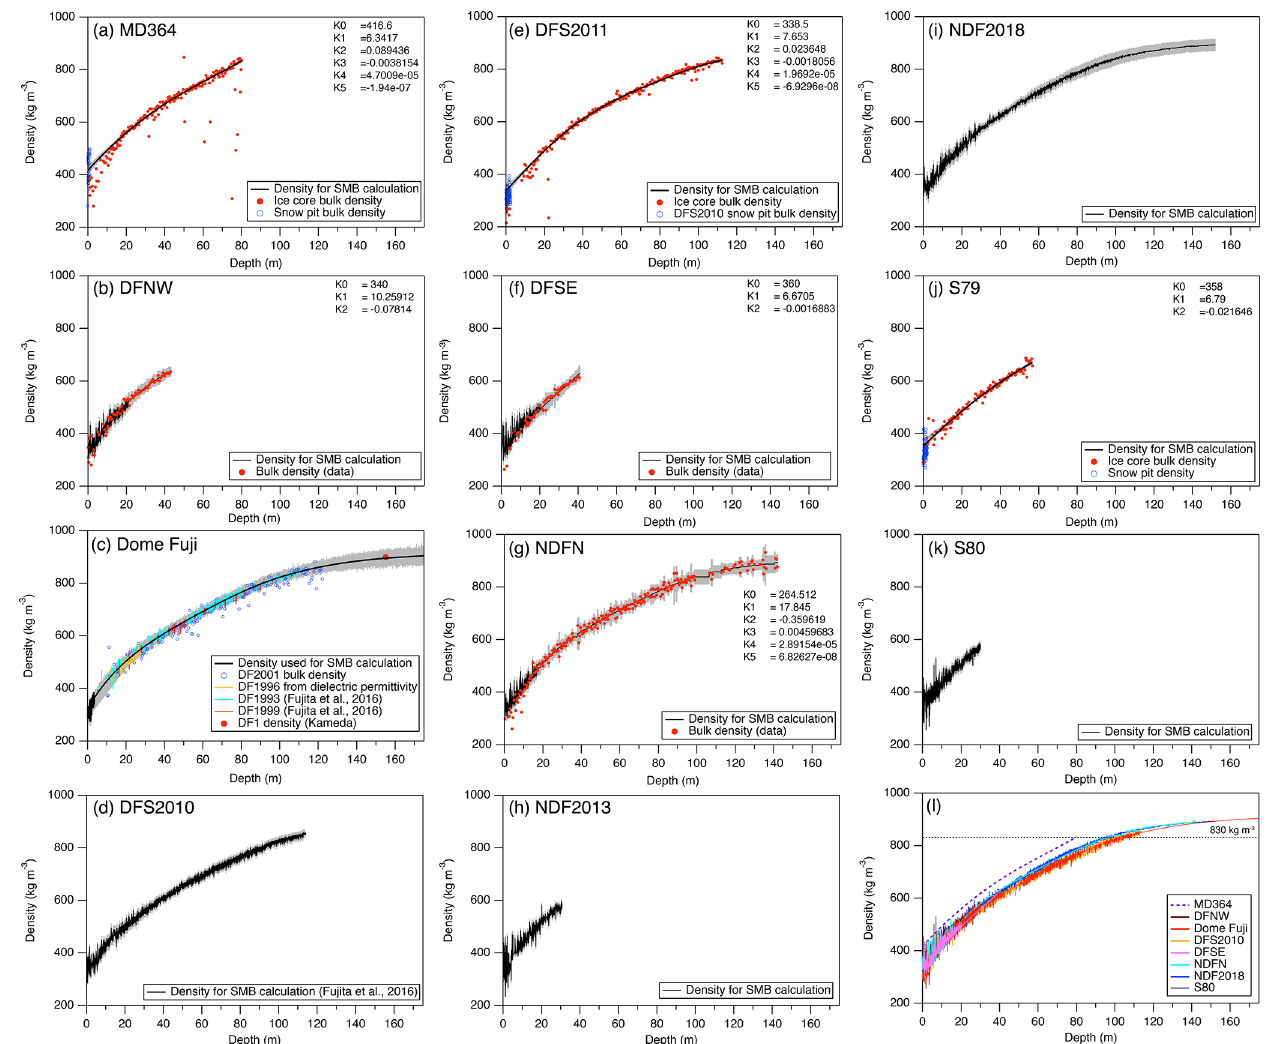
Figure 2. Density profiles of the studied sites. The black lines are the data used for the calculation of the accumulation rate, with 1 σ uncertainty shown using grey shading. Colored markers indicate bulk density data. K0, K1, K2, K3, K4 and K5 are coefficients for the quadratic or quintic fitting curves. See the main text for coefficients for the fitting curve for the Dome Fuji (Eqs. 4 and